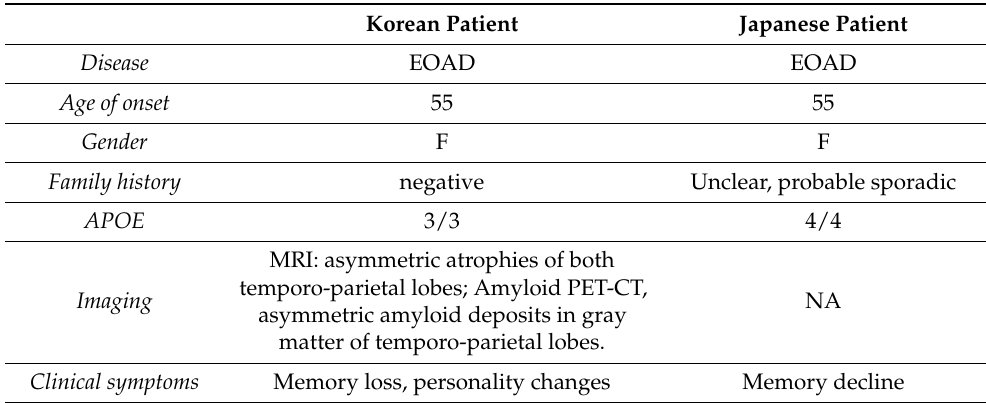
Table 1. Comparison of PSEN2 Thr421Met cases from Japan and the newly discovered Korean